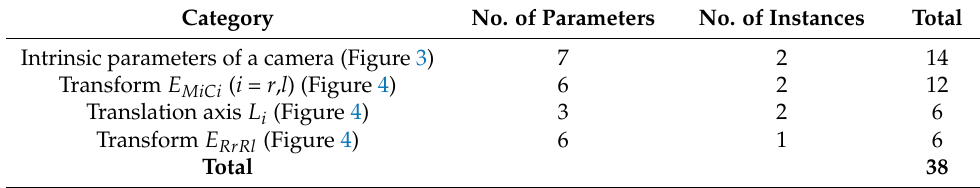
Table 4. List of parameters of the ASP to be